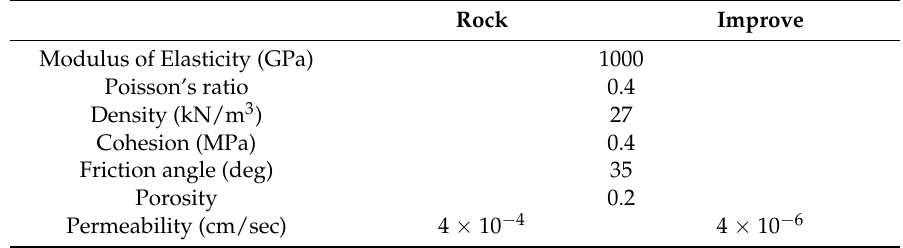
Table 1. The input parameters regarding rock mass used in numerical modeling.